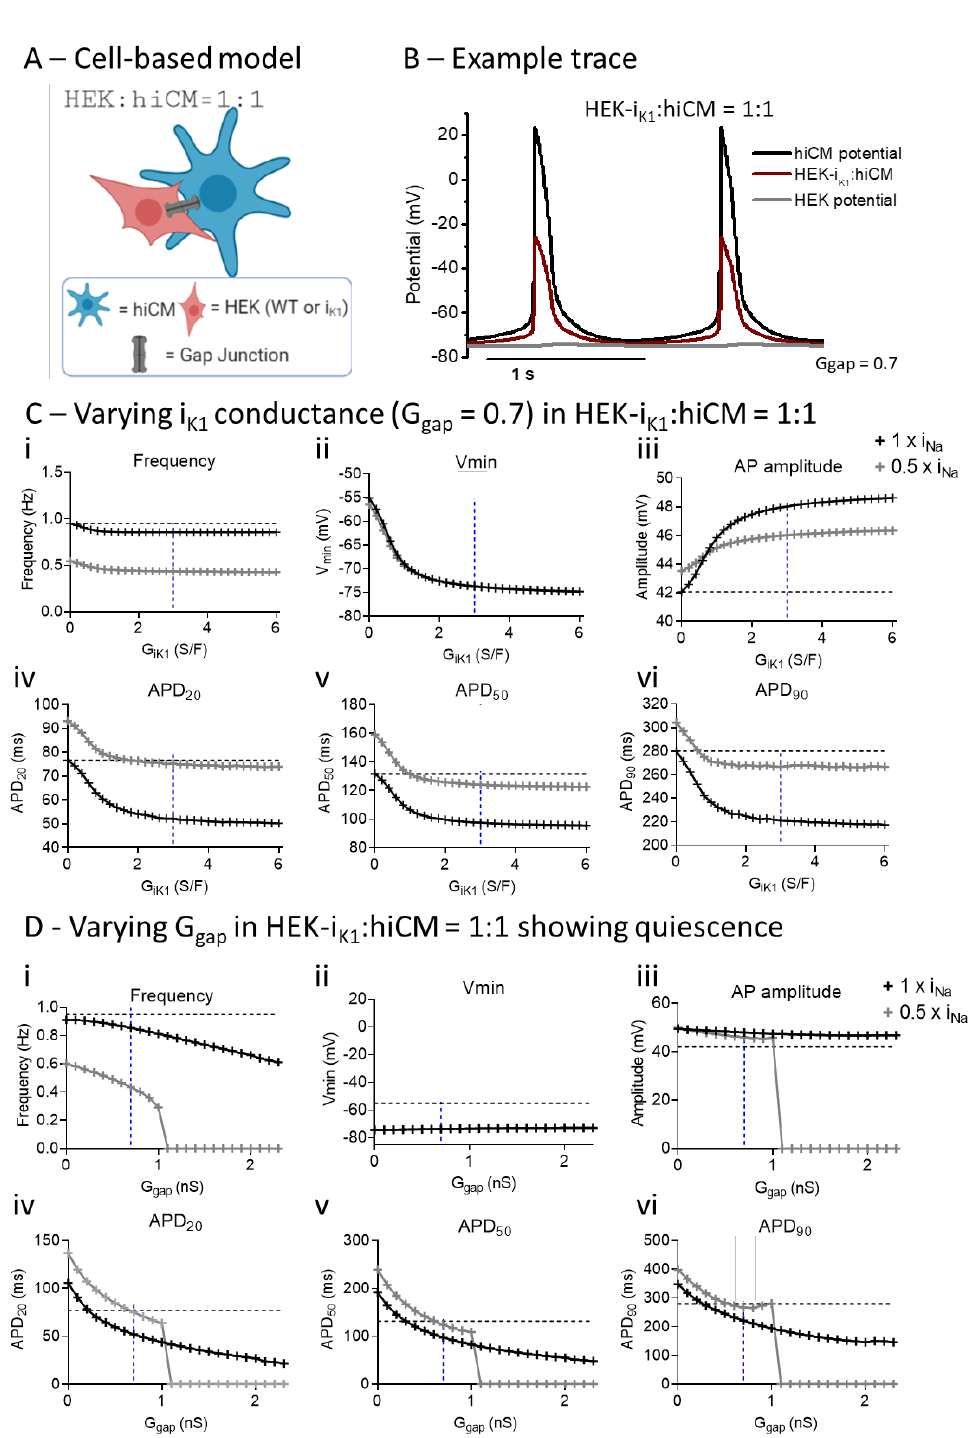
Figure 6. Computational modeling shows the effects of varying gap junction conductance (G gap ) and I K1 conductance (G IK1 ) in co-cultures of hiCM with HEK-I K1 and different Na + channel expressions. ( A ) Diagram of HEK:hiCM interaction used for computational model. ( B ) Example trace showing hiCM potential, HEK potential, and the average of the two. ( C ) Different parameters are affected by varying I K1 conductance in a full I Na model, and a half INa. ( D ) Electrophysiology is affected by increasing gap junction conductance in a co-culture of hiCM with HEK-I K1. In Figure 6D, the sensitivity of the two systems (HEK–WT:hiCM, HEK-I K1 :hiCM) to the value of G gap was explored by using the published G IK1 value of 3S/F [7] and varying